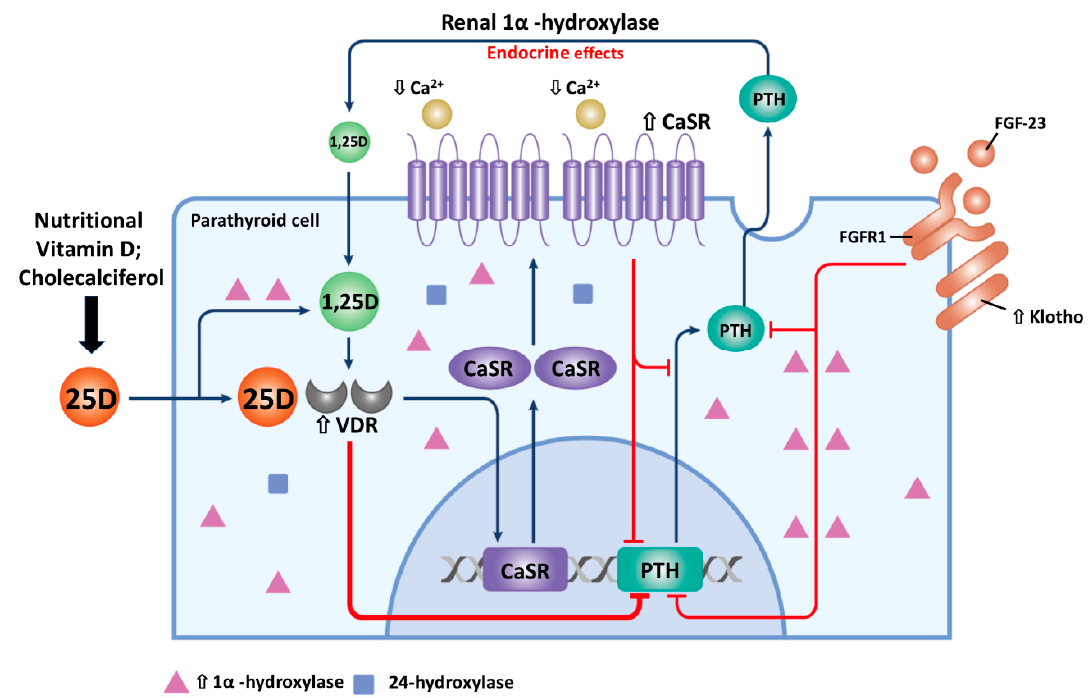
Figure 3. The adjuvant role of nutritional vitamin D (NVD) in SHPT treatment. NVD supplement had the benefit of increasing parathyroid 1,25D production and may synergize with calcimimetics and/or calcitriol by increasing CaSR and VDR expression which all contribute to suppress of PTH synthesis in PTG of SHPT. 1-hydroxylase and 24-hydroxylase are mitochondrial enzymes. (Abbreviation: NVD,